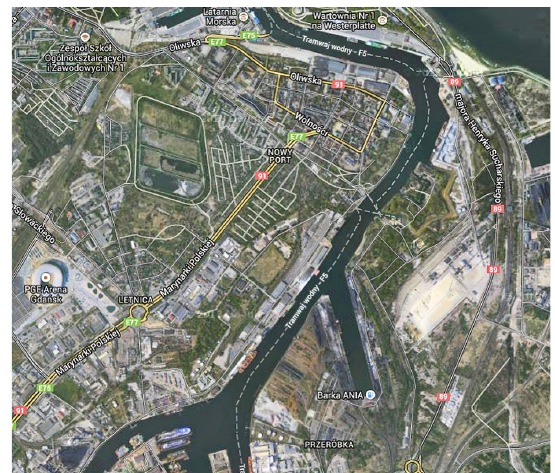
Fig. 1. A part of the Port of Gdańsk in the Martwa Wisła area (width of the navigational channel – about 88 m, ship turning basin – about 300 m in diameter)